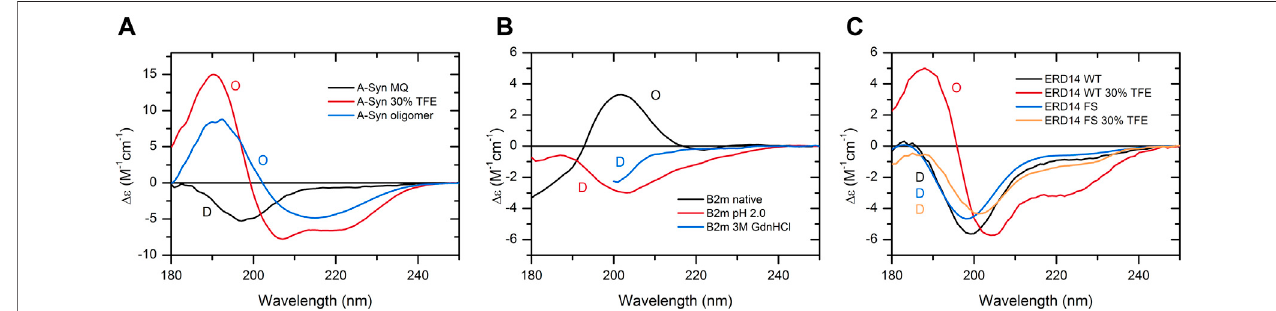
FIGURE5| Casestudiesshowingthestructuralvariabilityofindividualproteins,whichcanonlyberevealedexperimentally. (A) CDspectrumof α -synucleininwater is characteristic of a fully disordered chain. In 30% TFE, the protein exhibits an ordered, α -helix-rich conformation, and at higher concentrations (10 mg/ml), it readily formsoligomerswithaspectralshapeof β -structure. (B) Inthenativestate, β 2 -microglobulin( β 2m)exhibitsa β -sandwichfoldofanantiparallel β -structure.AtlowpHorin 3 M GdnHCl, its structure becomes disordered. (C) ERD14 disordered plant chaperone and its arti fi cial pair consisting of the full scrambled sequence both exhibit disordered structure in water. The presence of 30% TFE induces the formation of α -helix in the wild-type protein, while its scrambled variant preserves its disordered conformation. For (C) , experimental data modi fi ed from Murvai et al. (2021) were used with the authors ’ permission. The results of the binary classi fi cation are shown by O (ordered) and D (disordered) letters in the fi